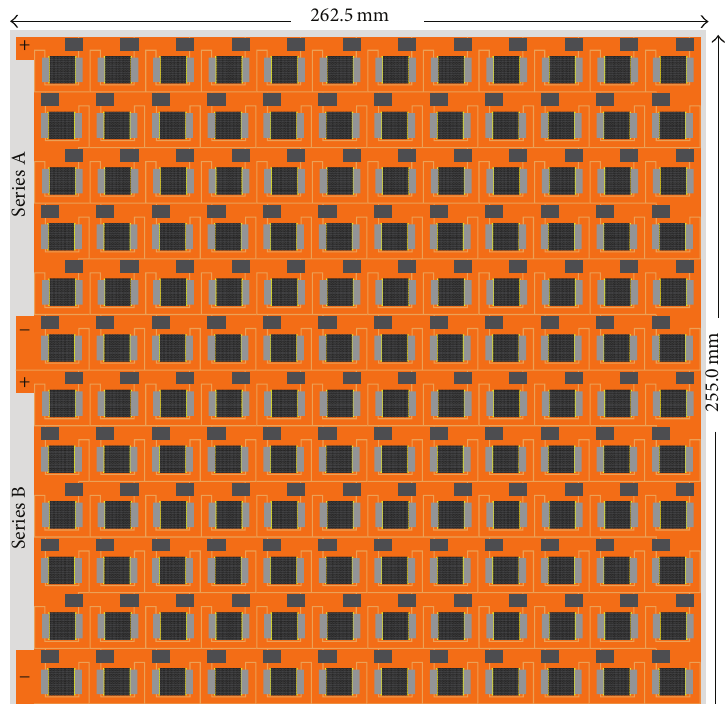
Figure 16: Complete assembly: the dimensions of the aluminum board are shown.